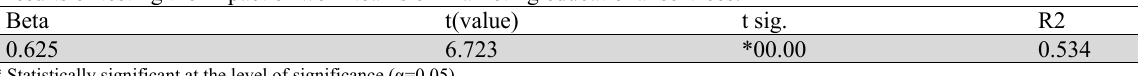
Results of testing the impact of work teams on marketing educational services.